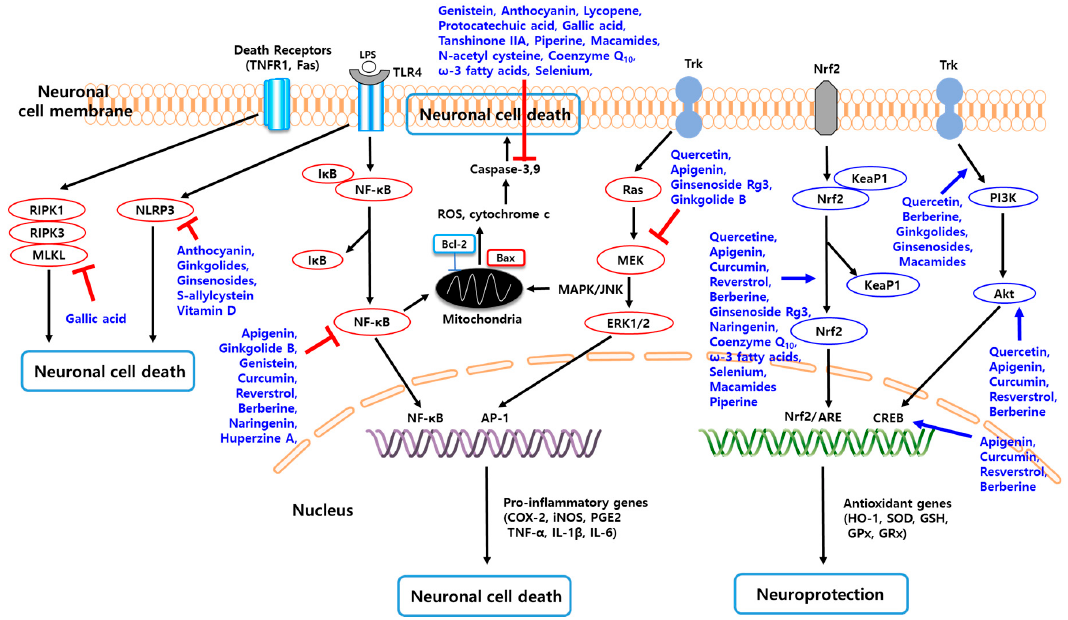
Figure 3. Molecular mechanisms of various natural compounds for the treatment of